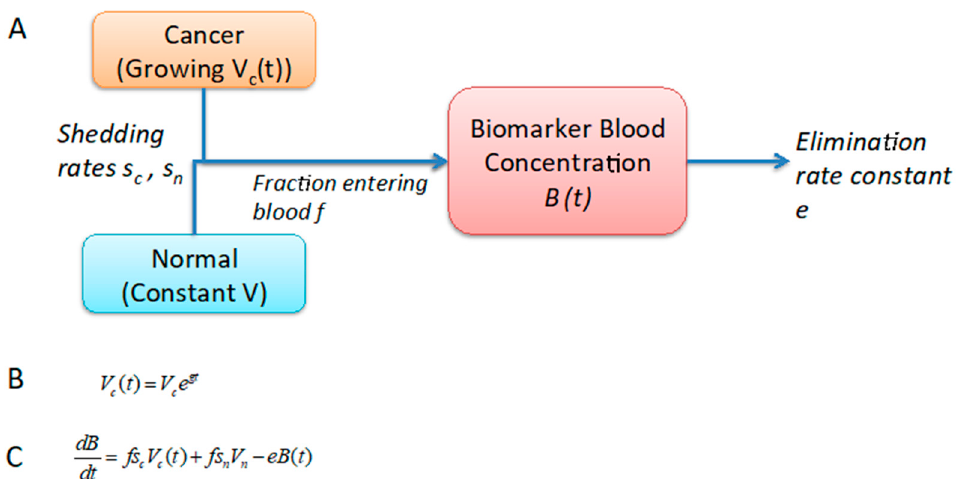
Figure 1. Schematic of the one-compartment mathematical model. ( A ) The one-compartment model models biomarker concentration in blood, where the biomarker can be shed by both normal and cancer cells and is eliminated at a constant rate. ( B ) The tumor growth equation is simple exponential growth based on autopsy measurements of tumor volumes, including primary and metastases. ( C ) Ordinary differential equation for biomarker production consisting of influx from tumor shedding and normal cell shedding, minus clearance from blood.